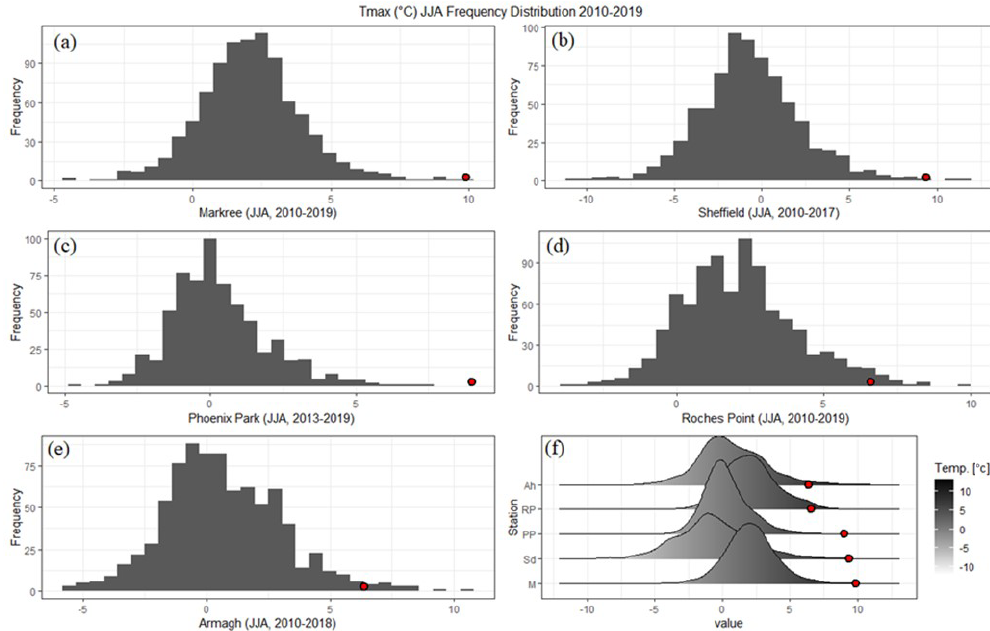
Figure 7. (a–e) Modern-day distribution for the JJA season differences between the maximum temperature of Kilkenny Greenshill and the five stations where the data were most available and (f) amalgamation of all of the stations for comparison purposes. Shown in red is the difference reported on 26 June 1887 between each station and Kilkenny